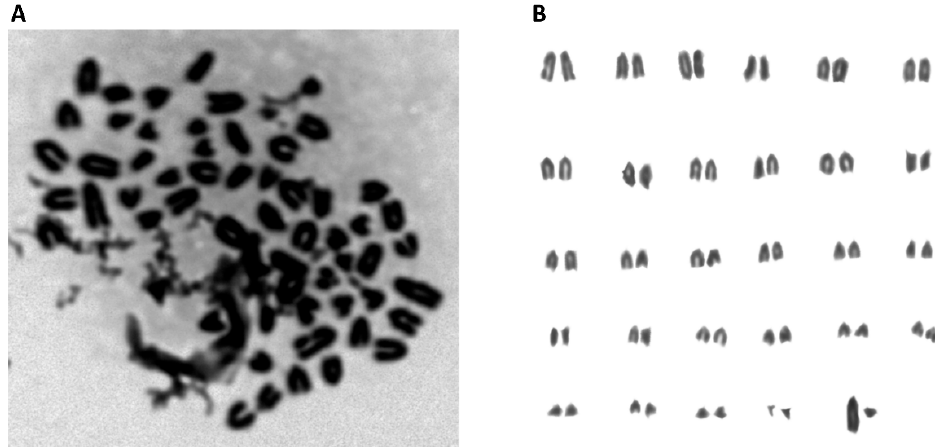
Figure 2. ( A ) Karyotype analysis of MSCs. Chromosomes were obtained from MSCs at M phase; ( B ) Karyotype analysis showed a normal karyotype. Fifty-eight chromosomes were revealed, including the XY sex chromosomes.